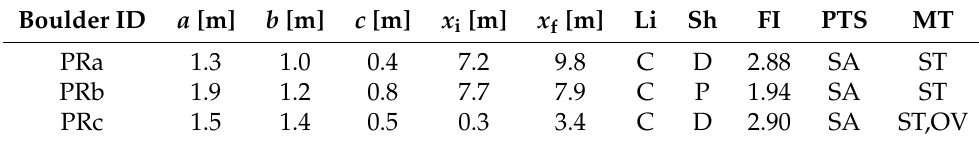
Table A2. Main features of the displaced boulders at Punta Prosciutto headland; Dimensions of the boulder axes a , b , c , initial distances from the cliff edge x i , final distances from the cliff edge x f . Li, Lithology; C, Calcarenite; L, Limestone; S, Sandstone; Sh, Shape; B, Bladed; P, Prolate, D, Disk; E, Equant; FI, Flatness Index; PTS, Pre Transport Setting; JB, Joint-Bounded, SA, Sub-Aerial;